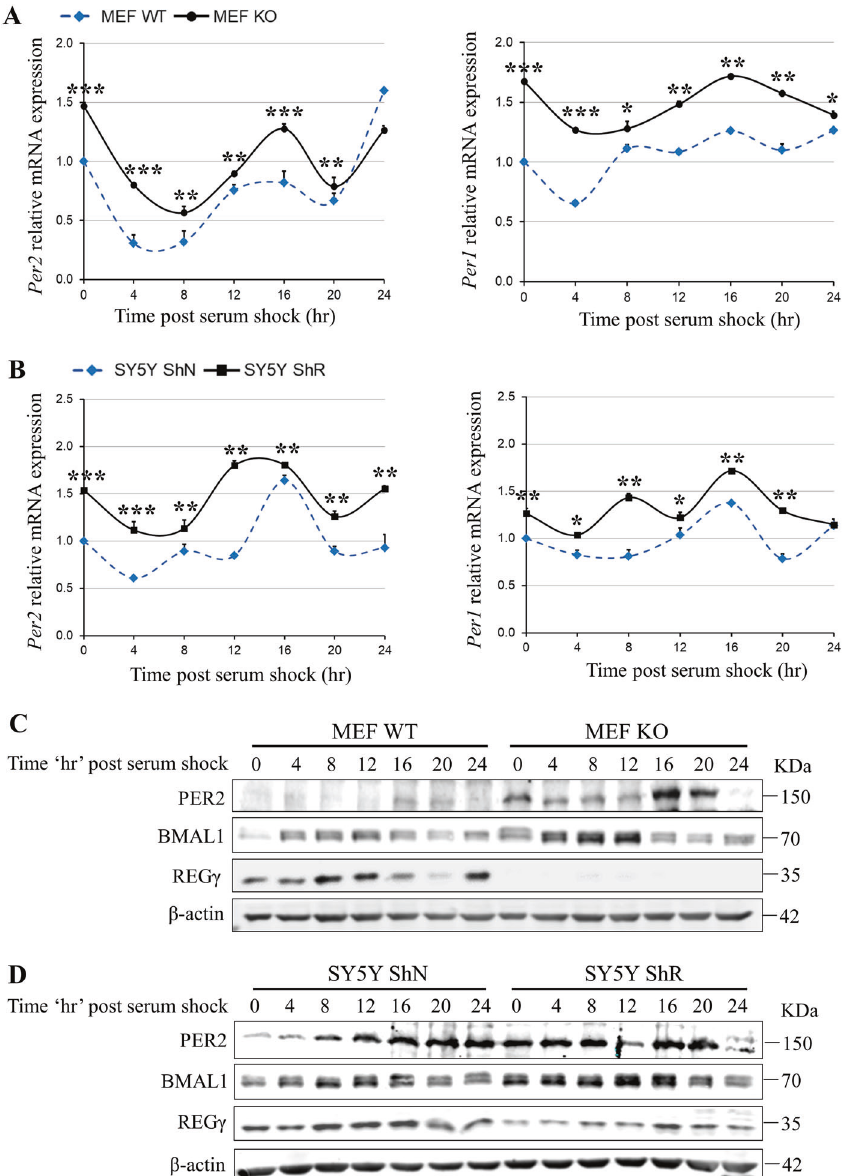
Fig. 3 REG γ depletion affects the rhythms of circadian gene expression in cultured cell lines. Real-time qPCR analysis of circadian genes in A primary MEF WT/KO cells and B SY5Y ShN/ShR cells treated with 50% horse serum and then collected the cells at 4 h intervals across a 24-h cycle; the target gene expression levels were analyzed relative to the ribosomal RNA gene 18S. Immunoblots of REG γ and circadian components PER2 and BMAL1 in C MEF and D SY5Y cells. Values represent the mean ± SD. *** p < 0.001, ** p < 0.01, * p < 0.05; t test, WT vs. KO; ShN vs.